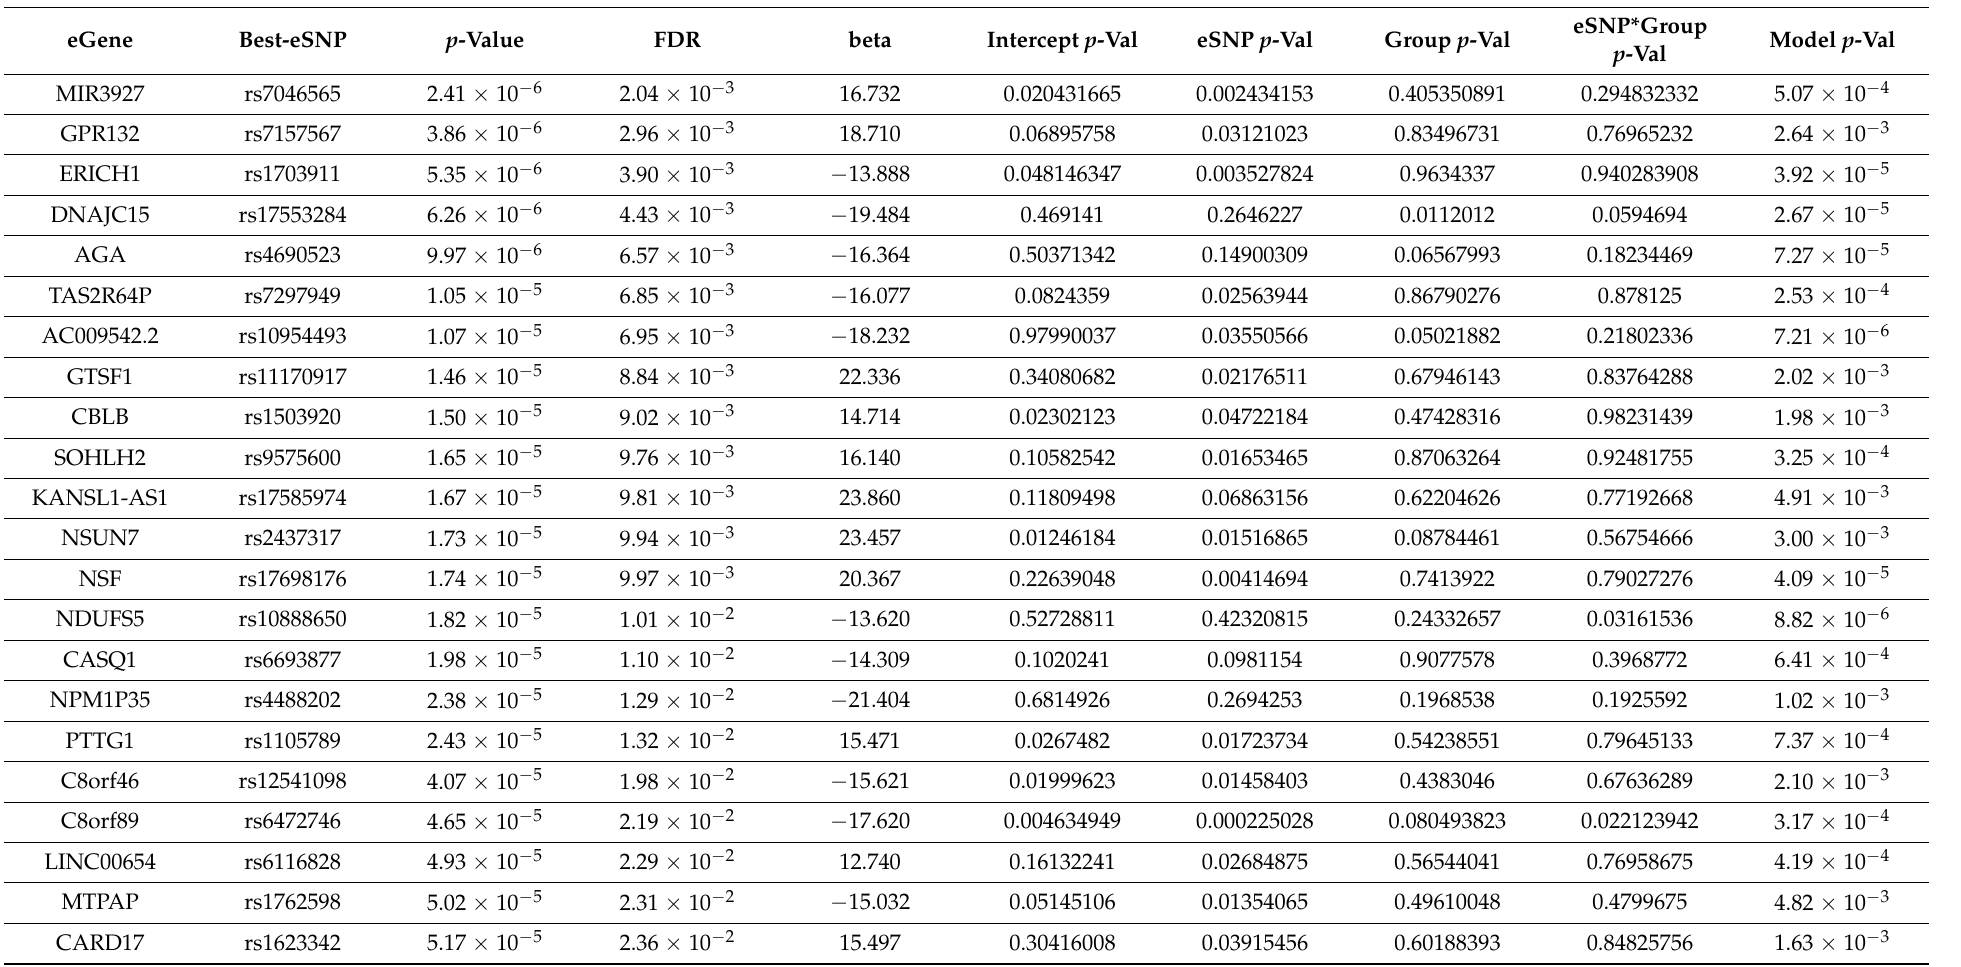
Table 4. Cont. From MatrixEQTL Analysis MINUS DISEASE From Linear Regression to Test Genotype-Disease